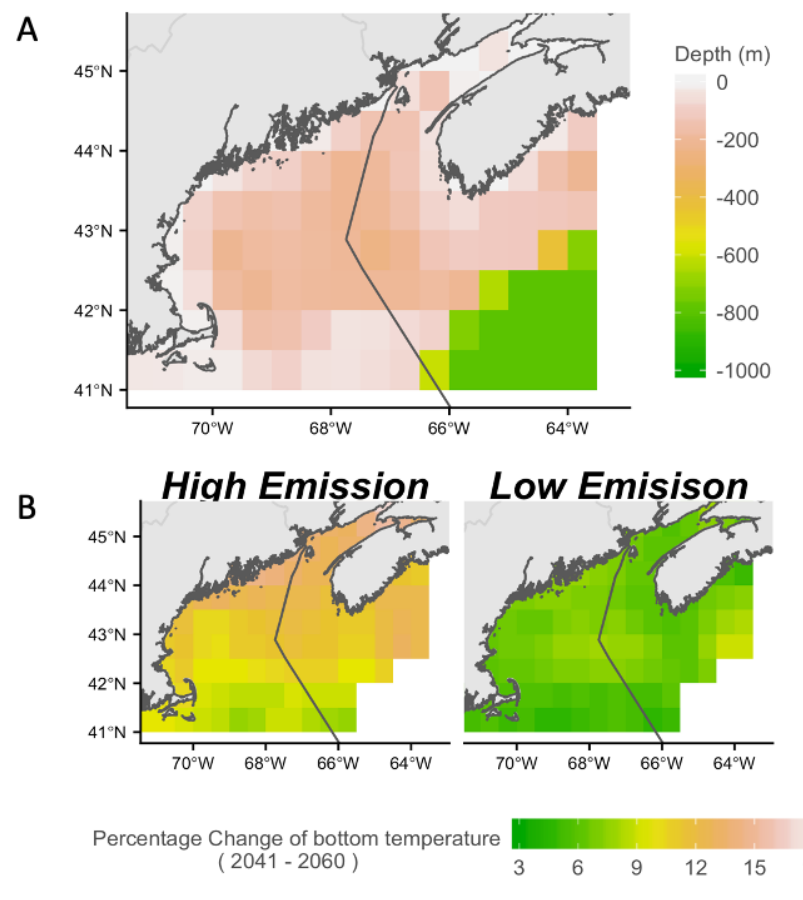
Fig. A2.2. Depth profile (A) and bottom water warming of the Gulf of Maine. Everything deeper than 1000 meters is colored in green. B) Percentage change of bottom temperature relative to the present showing more intense warming in northern regions, especially under a high emission climate change